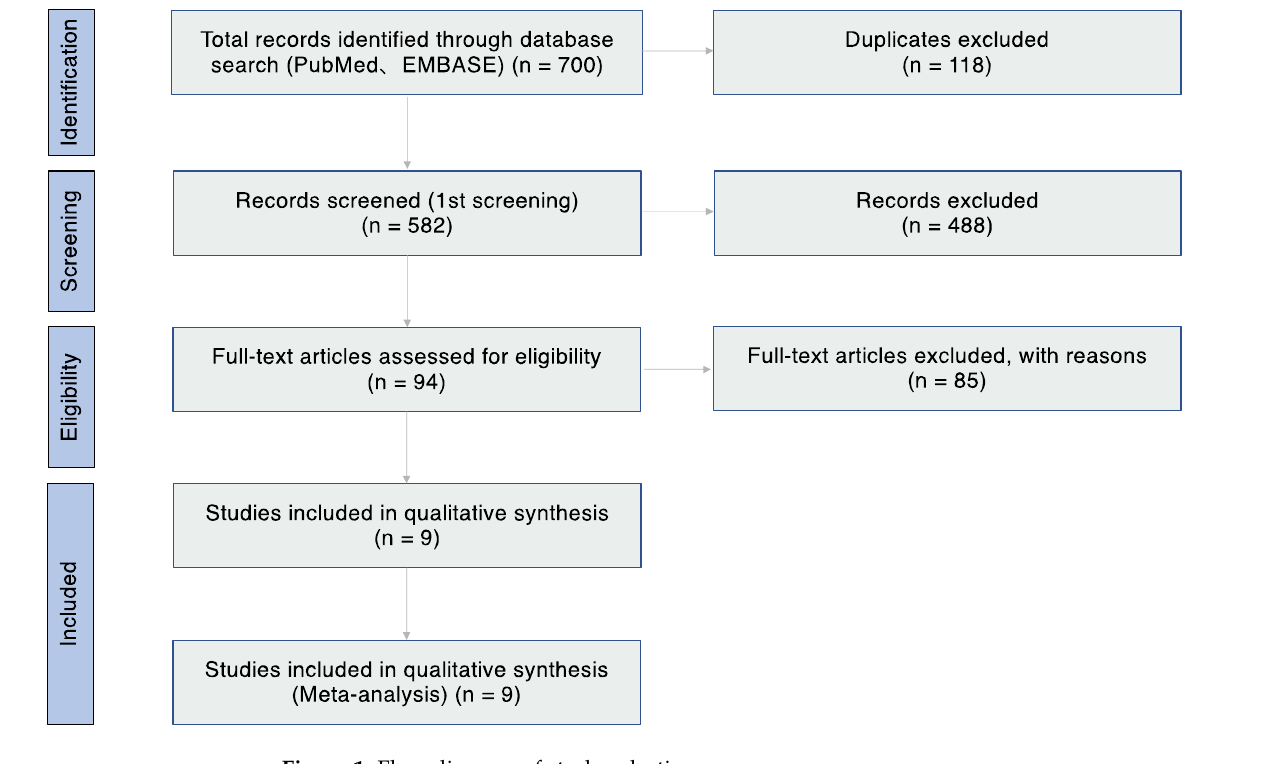
Figure 1. Flow diagram of study selection.